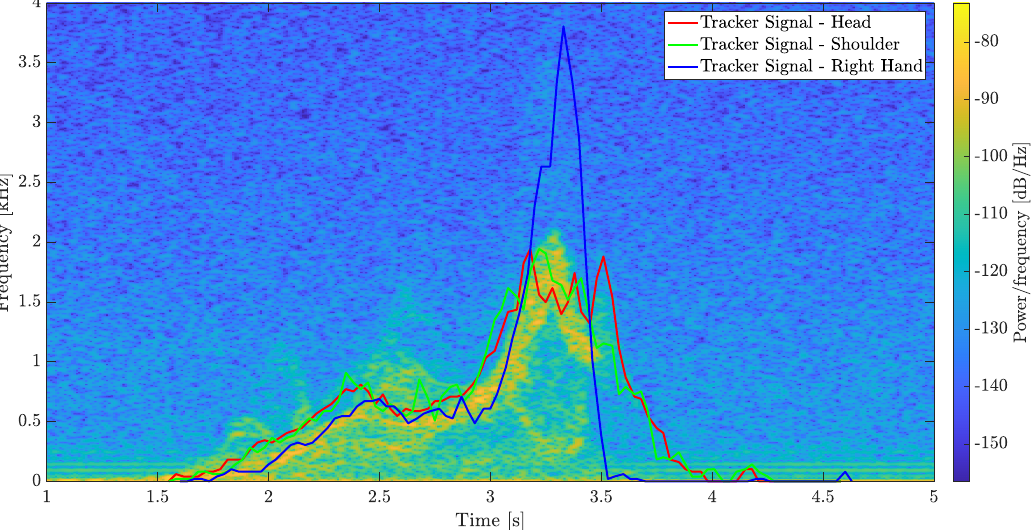
Figure 14. Presentation of the measurement results for a man falling while walking. The spectral signature was measured using the MMW radar, and the colored lines indicate the data obtained through tracking the subject’s head, shoulder and right hand in a recorded video.